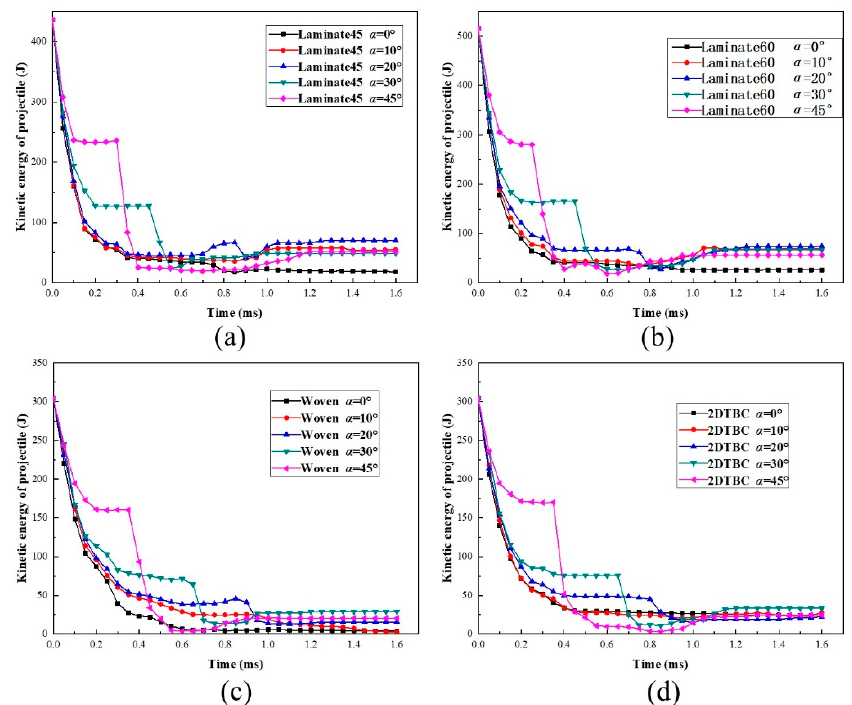
Figure 7. Evolution of kinetic energy of projectile for composite panels against the change of α : ( a ) Laminate45 at V cr,n = 115 m / s, ( b ) Laminate60 at V cr,n = 125 m / s, ( c ) woven panel at V cr,n = 96 m / s, ( d ) 2DTBC panel at V cr,n = 96 m / s.